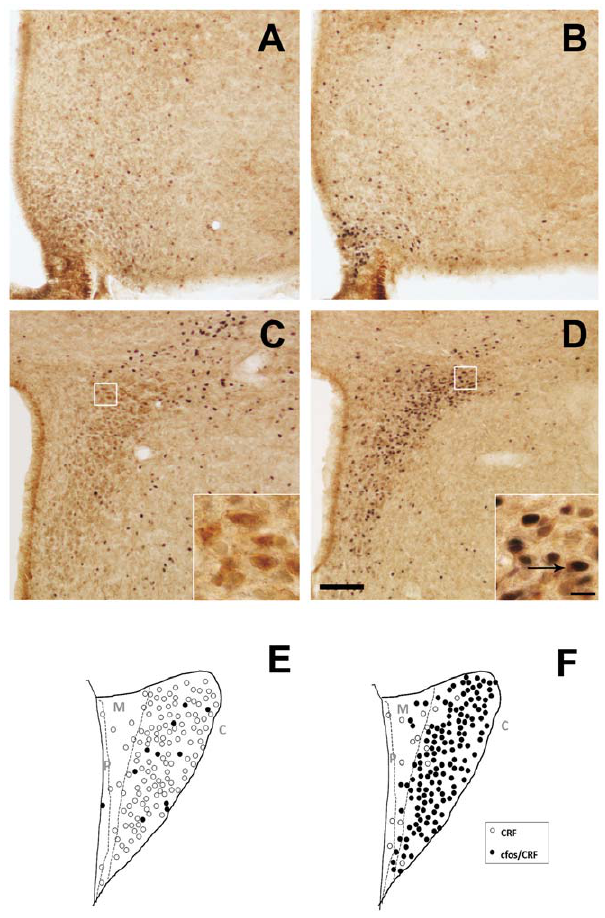
Figure 1. Ghrelin administration activates CRF neurons of the PVN. Panels A to D show representative photomicrographs of brains sections subjected to double immunohistochemistry using anti-CRF (brown staining) and anti-c-fos (purple-black staining) antiserum. Upper panels show the ARC and bottom panels show the PVN. Images of panel A and C are from a vehicle-treated mouse and images of panel B and D from a ghrelin-treated mouse. Inserts in PVN images show high magnification of areas marked in low magnification images. Arrows point to dual-labeled cells. Scale bars, 100 m m (low magnification), 10 m m (high magnification). Panels E and F show schematic drawings of middle level of the PVN of a vehicle- and ghrelin-treated mouse, respectively. Filled circles represent CRF-IR neurons positive for c-fos, and open circles indicate single-labeled CRF-IR cell bodies. Gray letters indicate the PVN subdivisions: P: periventricular; M: medial; C: compact.